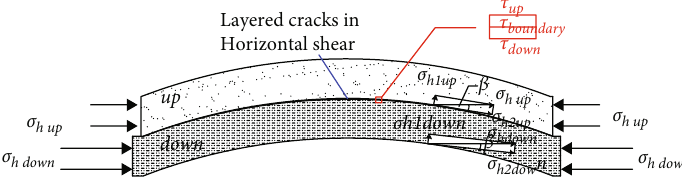
Figure 3: Sketch of formation of horizontal shear layer to fi